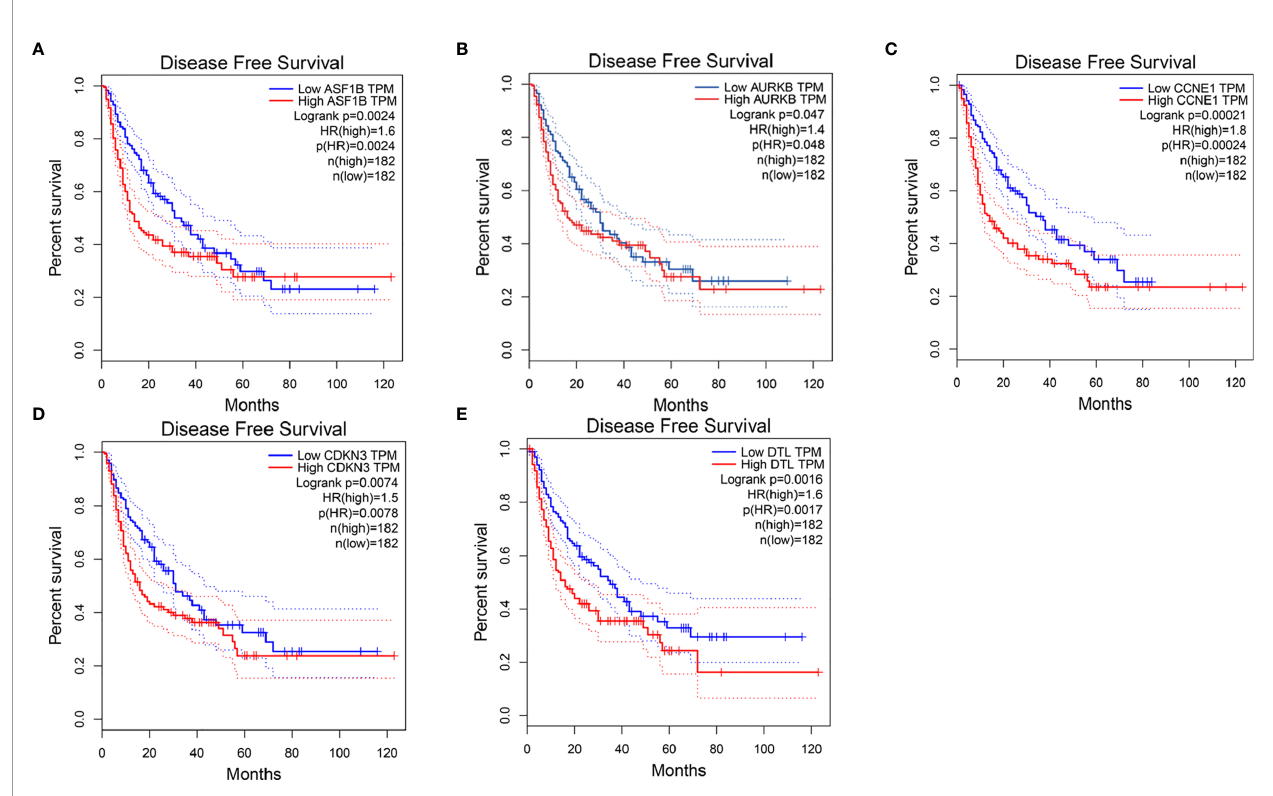
FIGURE 4 | Disease-free survival analysis of (A) ASF1B, (B) AURKB, (C) CCNE1, (D) CDKN3, (E) DTL by using